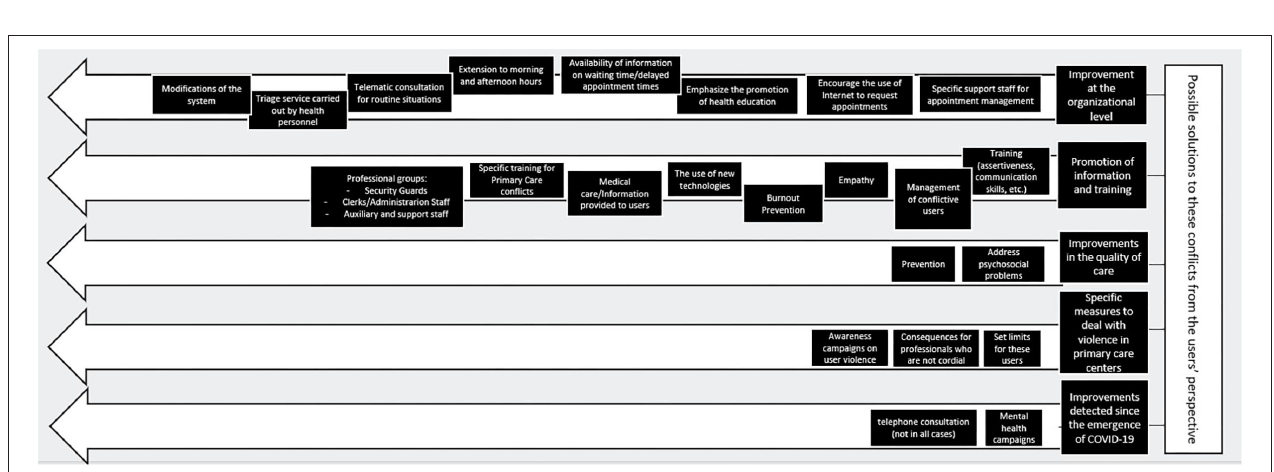
FIGURE 1 | Sources of conflict in Primary Care centers from the users’ perspective: topics and subtopics.